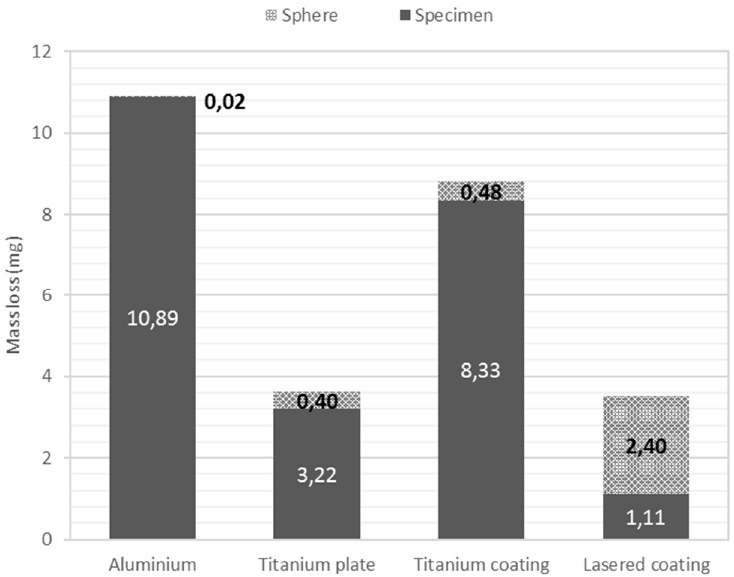
Figure 6. Wear comparison in term of mass loss for the four processing methods.